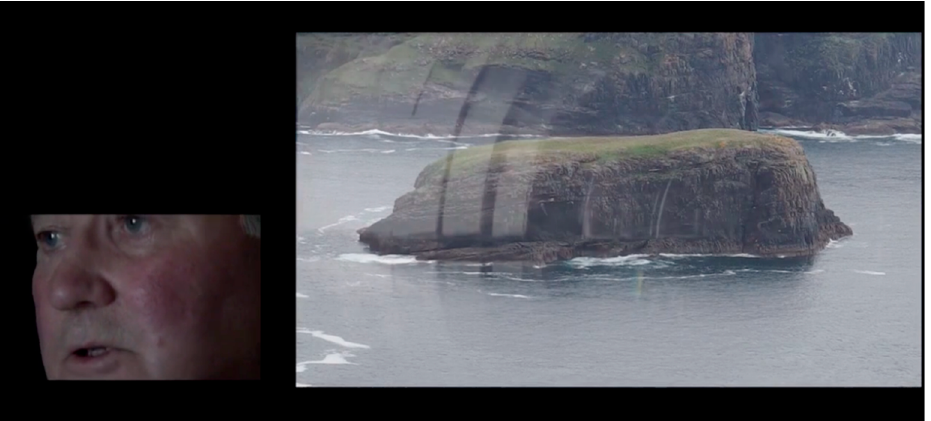
Figure 13. Screenshot Mapping the Sea: Barra (2013), Stephen Hurrel, commissioned by Cape Farewell. Image used with permission form the artist.